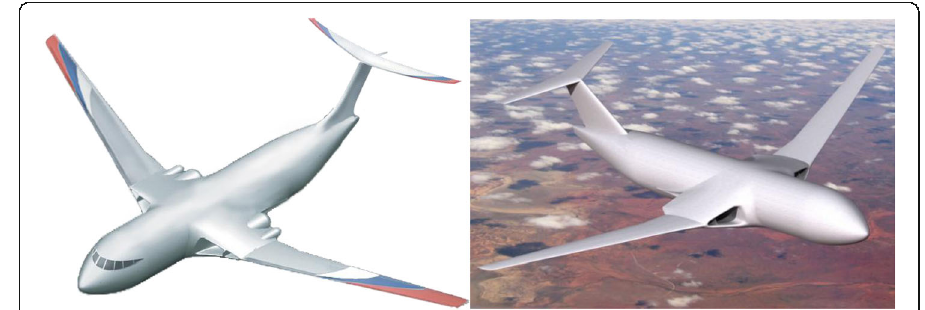
Fig. 4 Aircraft with powerplant distributed within wing